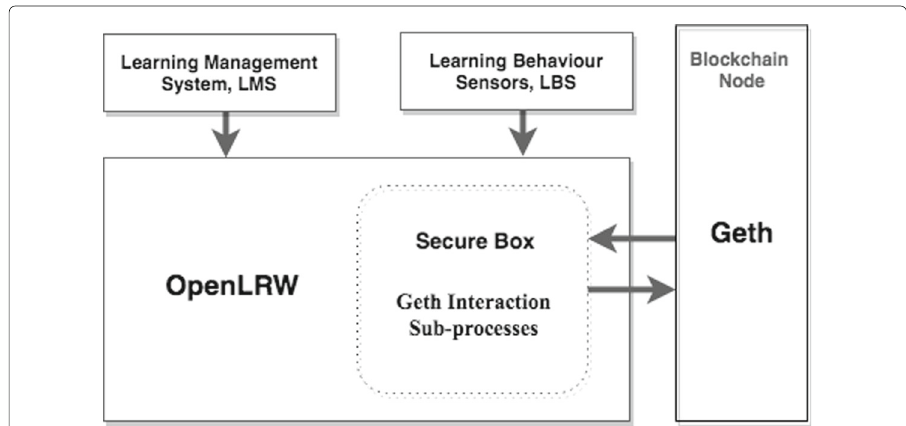
Fig. 3 BOLL architecture—one institution. To enable the use of BOLL at an institution, it is required to have a learning management system or learning behaviour sensors, a learning record store, a secure box, and a blockchain node. This figure shows these key requirements and how they are interfaced